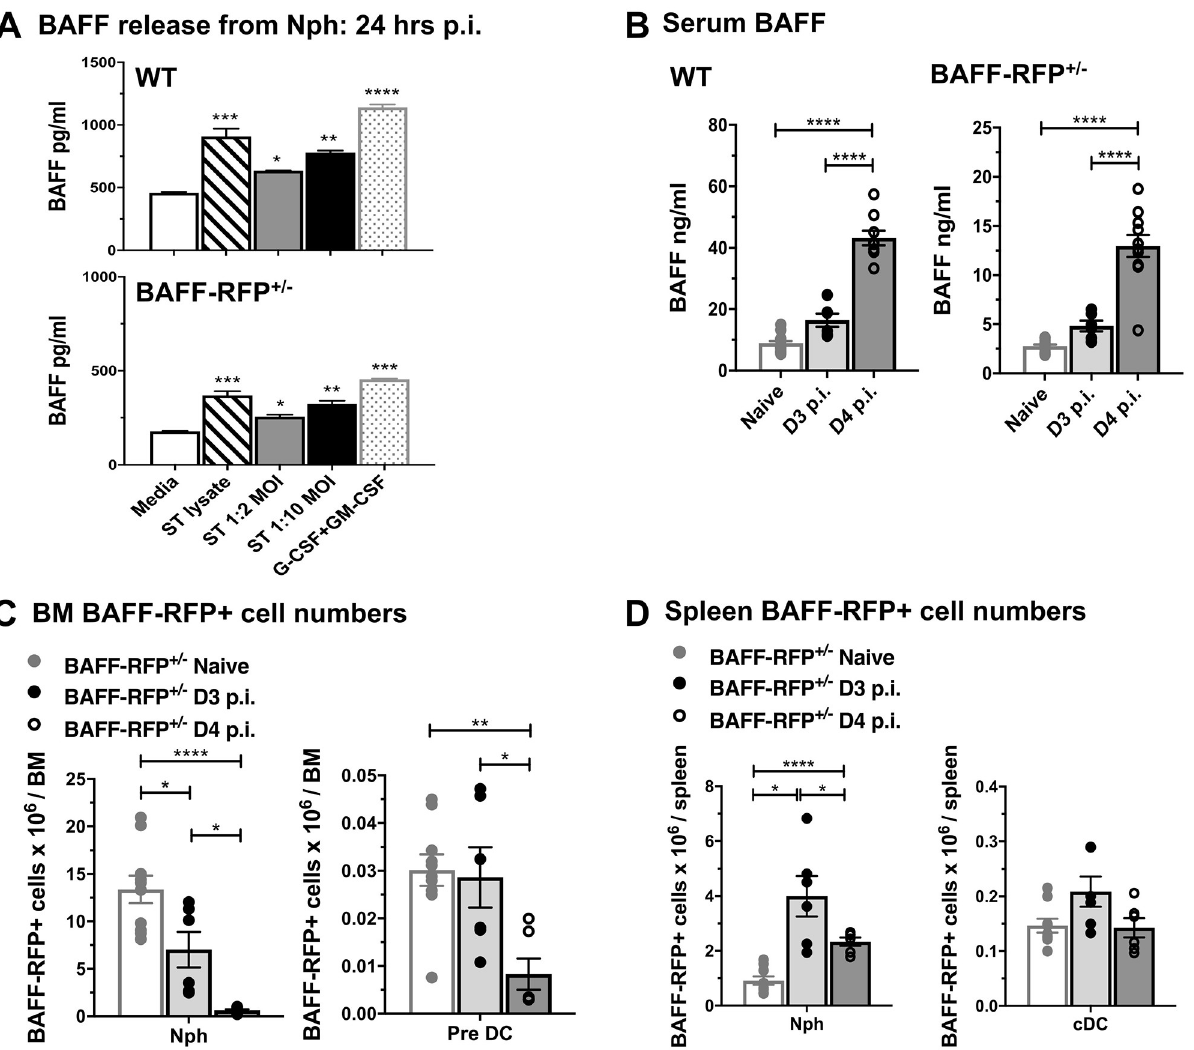
Fig 4. S . typhimurium induces release of BAFF from Nphs, increase in systemic BAFF levels and expansion of splenic BAFF-RFP + Nphs. (A) WT and BAFF-RFP +/- mice BM Nphs were isolated and BAFF was measured from supernatants of Nphs stimulated for 24 hrs with live S . typhimurium or bacterial lysates. G-CSF plus GM-CSF was used as a positive control. Data show one representative experiment of four independent experiments. (B-D) BAFF-RFP +/- mice were infected i.p. with 500 CFU S . typhimurium . (B) BAFF titers in the serum of na ï ve and infected WT and BAFF-RFP +/- mice were measured by ELISA. Graphs summarize data from four independent experiments (n = 6–14). BM (C) and spleens (D) from na ï ve and infected mice were analyzed by flow cytometry. Graphs show total numbers of BAFF-RFP + Nphs and cDCs and summarize data from three independent experiments (n = 6–10). Bar graphs show means ± SEM; � p < 0.05, �� p < 0.01, ��� p < 0.001, ���� p < 0.0001, as determined by One-Way Anova with Holm-Sidak multiple comparisons test. (ST refers to S . typhimurium ).